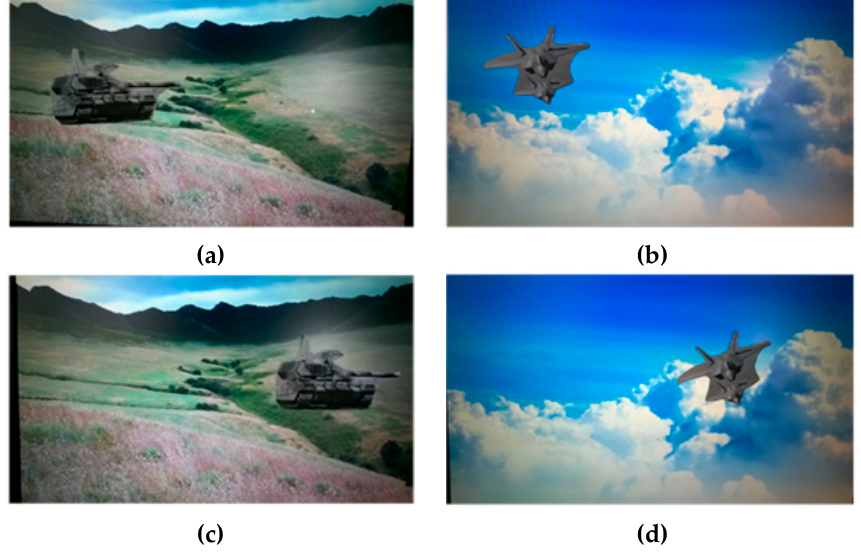
Figure 12. Frames in the video clips showing prairie (( a ) and ( c )) and sky (( b ) and ( d )).